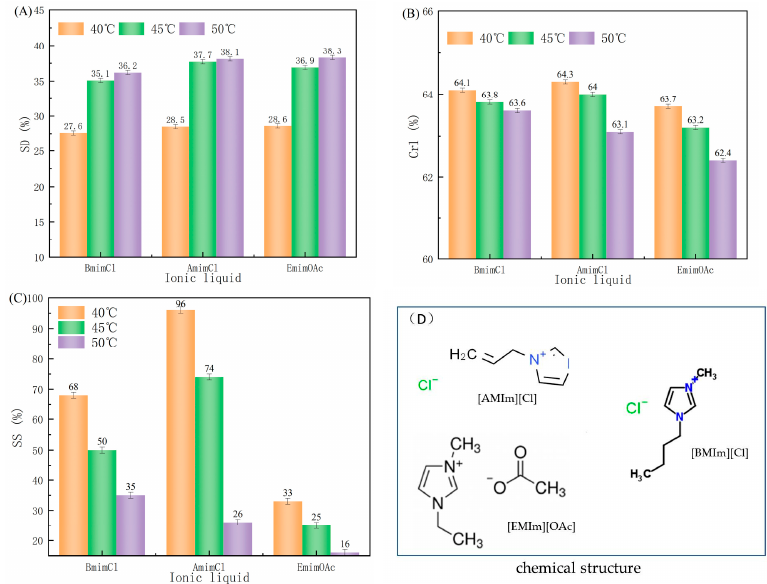
Figure 1. Effects of different species of ionic liquids on ( A ) swelling degree, ( B ) crystallinity degree, and ( C ) swelling selectivity of MCC. ( D ) Chemical structures of the three ionic liquids.